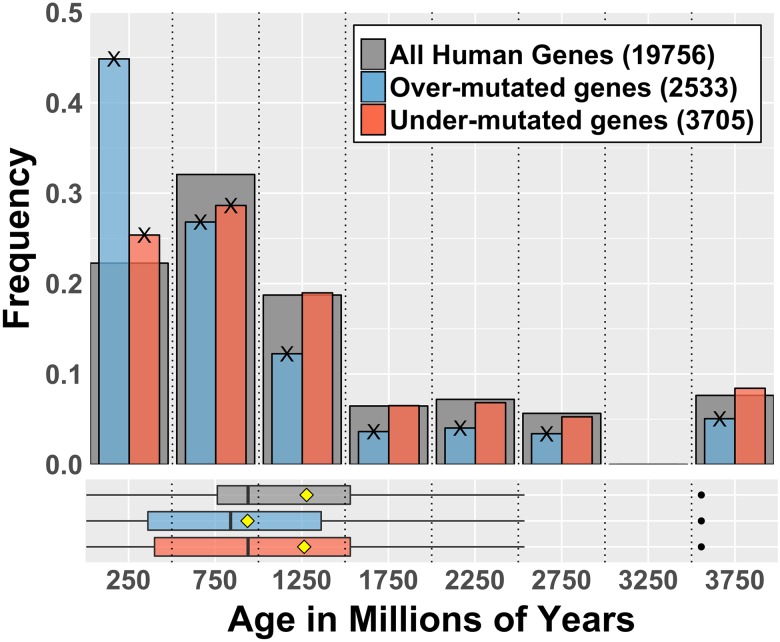
Cancer displays a distinct mutational pattern relative to normal based on the evolutionary age of genes.For each human gene, the expected number of mutations is obtained based on the normal mutation pattern: frequency of normal mutations times the total number of cancer mutations recorded in the data set. According to this, the Enrichment Ratio (ER) is calculated as the ratio of observed cancer mutations and the number of expected mutations in the gene. Over-mutated genes have ER > 1.5; under mutated genes have ER < -1.5. Numbers in legend indicate the size of each gene set. Cross marks (X) on bars tips indicate the enrichment in that category is statistically significant at p < 0.01 according to a bootstrap test taking random samples from the set of all human genes (BSQ < 1%, see Table 1). Boxplots in lower panel show distribution quartiles; black vertical lines are medians, yellow diamonds are means and black dots are outliers.